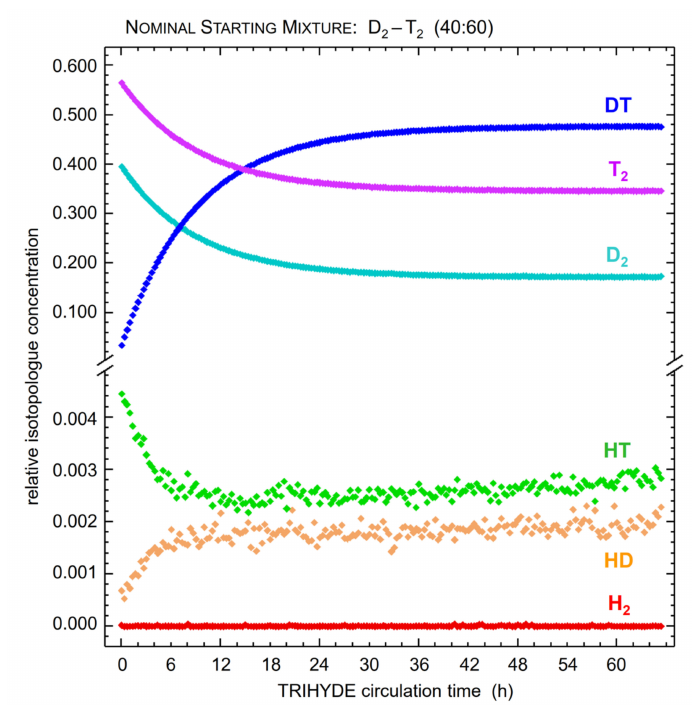
Figure 5. Evolution of the composition of a D 2 -T 2 sample (nominal starting mixture 40:60), associated with β -induced self-equilibration processes. Note that the T 2 batch purity in the data shown here was only 97.5%, with most of the remainder being DT. The isotopologue concentrations shown here were extracted from the Raman spectra (signal intensity integrals of the Q 1 -branches); data points represent averages over time intervals of 20 min (corresponding to 20 individual LARA acquisitions). For further details, see